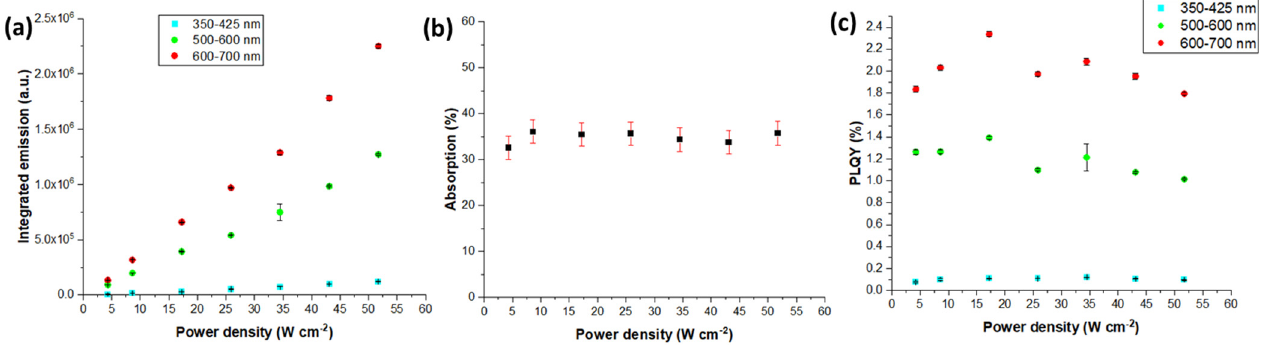
Figure 3. The following data was obtained for NaYF 4 :(20%)Yb 3+ , (3%)Er 3+ phosphor at different 980 nm laser excitation power densities: ( a ) integrated emission; ( b ) absorption; ( c ) PLQY.